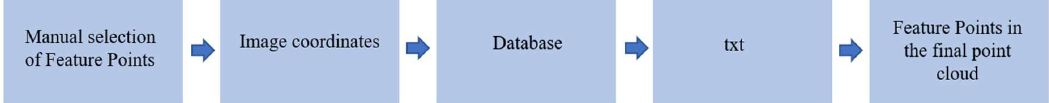
Figure 6. Workflow of the Feature Point selection step of the SfM